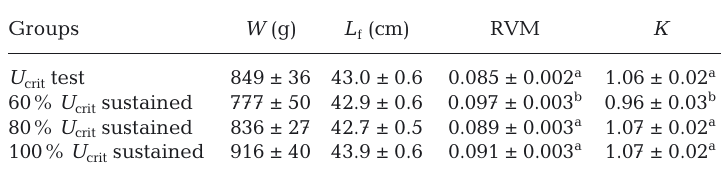
Table 1. Weight ( W ), fork length ( L f ), relative ventricular mass (RVM) and con- dition factor ( K ) of the 4 test groups of Atlantic salmon (n = 24). Superscript letters indicate a significant difference (p < 0.05). Data are means ± SE